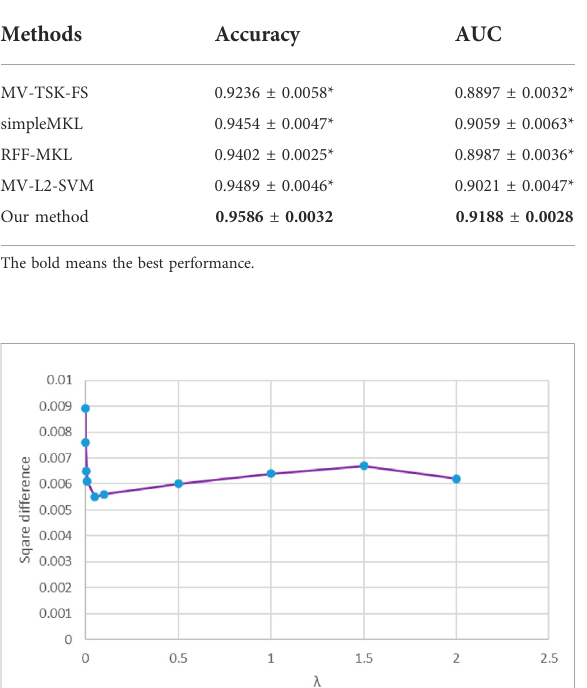
FIGURE 7 Square difference against the regularized parameter λ